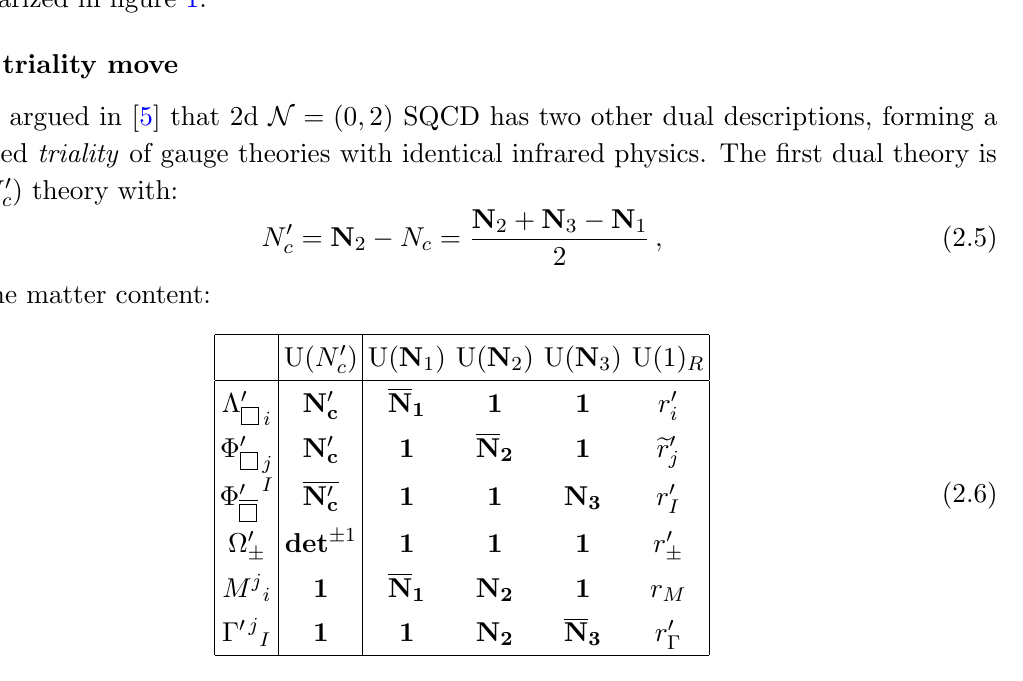
Figure 1 . The quiver diagram of 2 d in the determinant representation of U( N c ) are omitted to avoid